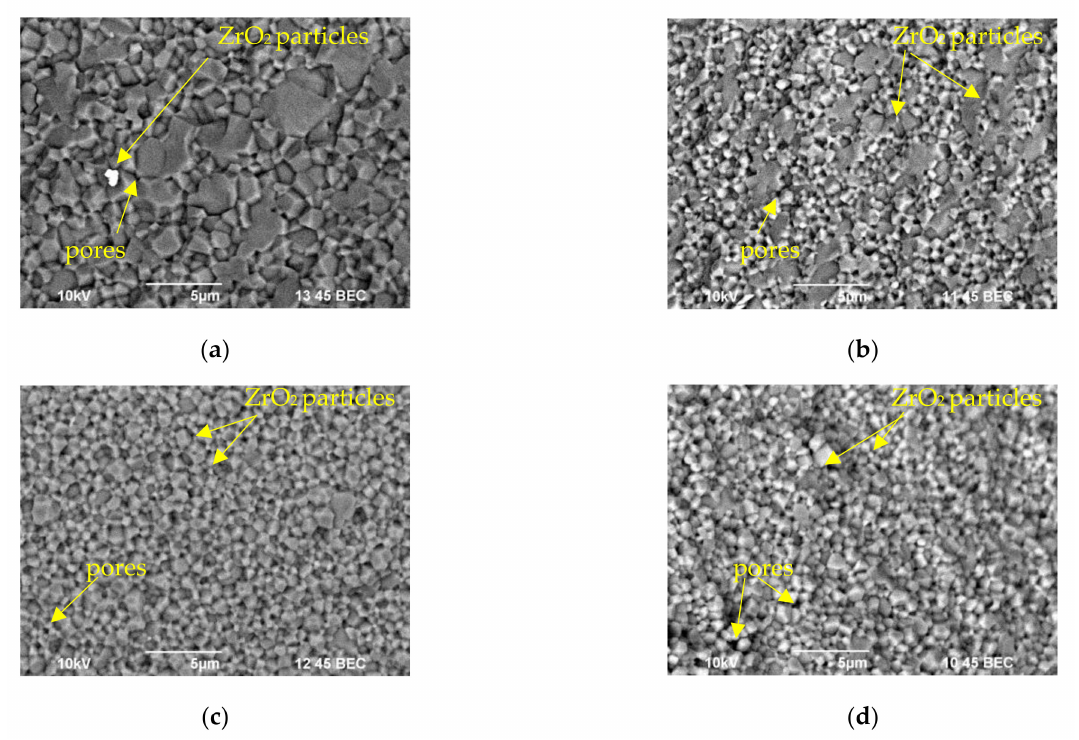
Figure A4. Fracture surfaces of α -Al 2 O 3 + 0.5%vol. ZrO 2 samples obtained at Т = 1520 ◦ C at: ( a ) 10 ◦ C/min, ( b ) 100 ◦ C/min, ( c ) 350 ◦ C/min, ( d ) 700 ◦ C/min. Gray grains are Al 2 O 3 , white particles are ZrO 2 .